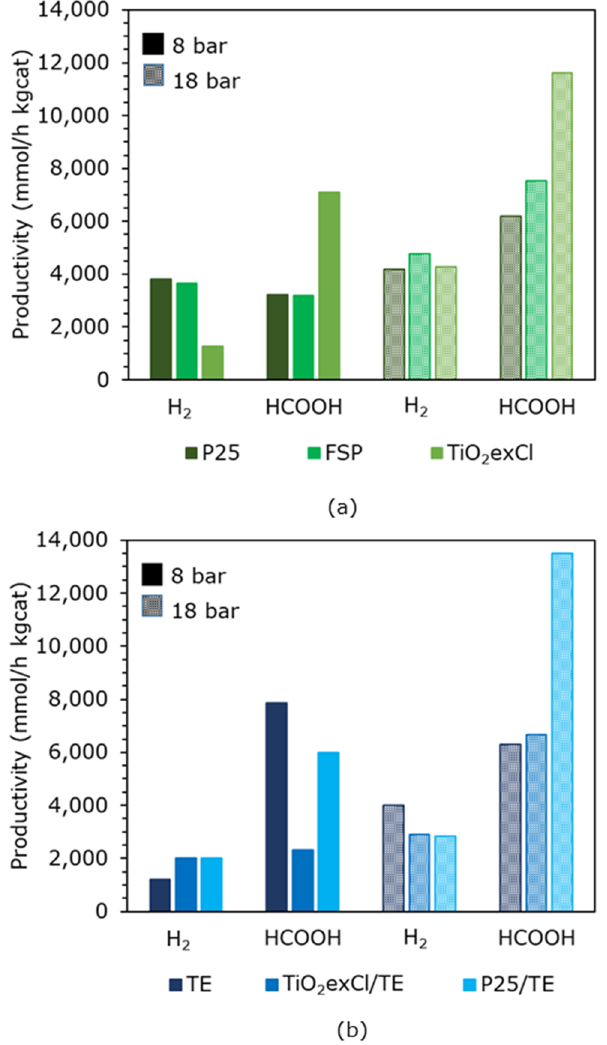
Figure 5. Effect of pressure on product distribution and productivity at 8 and 18 bar with pH = 14, 31 mg/L of catalyst, and 1.67 g/L of HS; reaction time 24 h. ( a ) TiO 2 photocatalysts and ( b ) bare C 3 N 4 and TiO 2 /C 3 N 4 composites. For brevity, the name of C 3 N 4 -TE sample is here reported as TE.